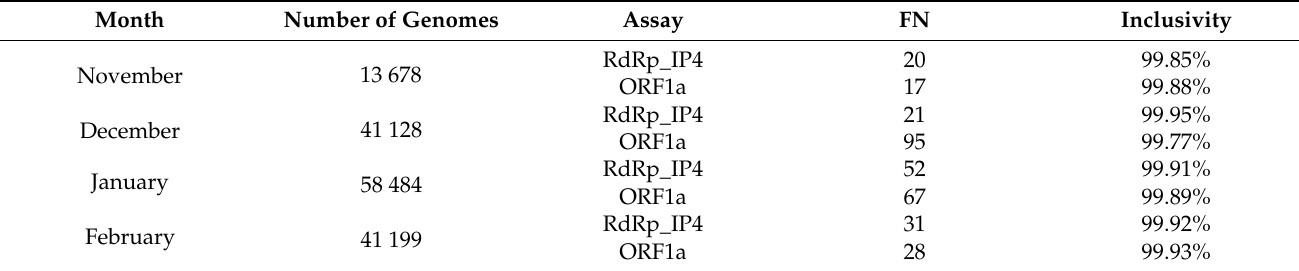
Table 2. Inclusivity in silico evaluation of ORF1a and RdRp_IP4 assays obtained with SCREENED.